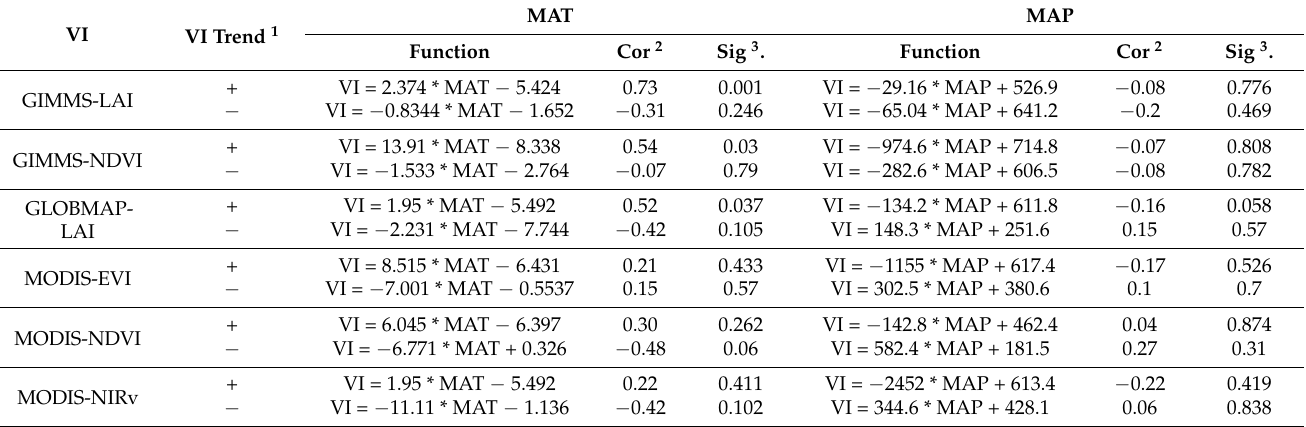
Table 2. Dynamics of climate with the significant changes in vegetation indices